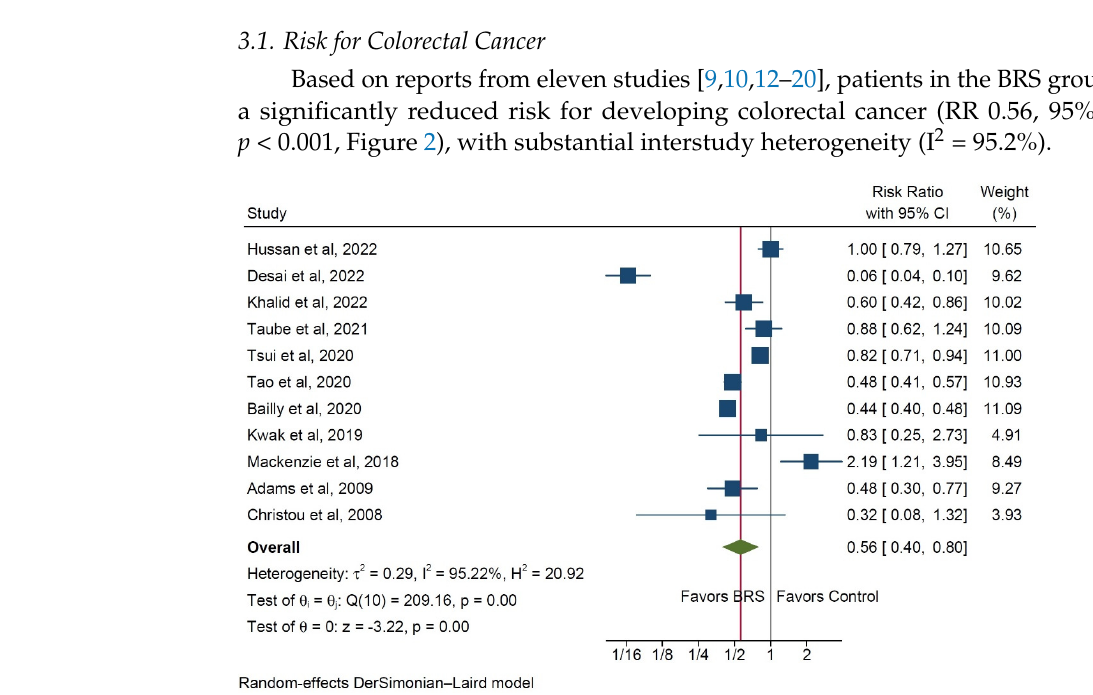
Figure 2. Forest plot of incidence rates of colorectal cancer in the bariatric surgery and control groups [9,10,12–20]. When different types of bariatric procedures were considered, sleeve gastrectomy was found to be significantly associated with fewer cases of colorectal cancer (RR 0.55,